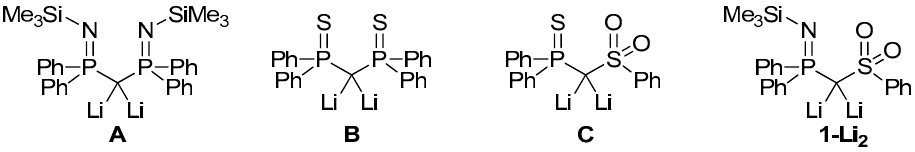
Figure 1. Isolated dilithiomethanes used as ligands for carbene complex formation.